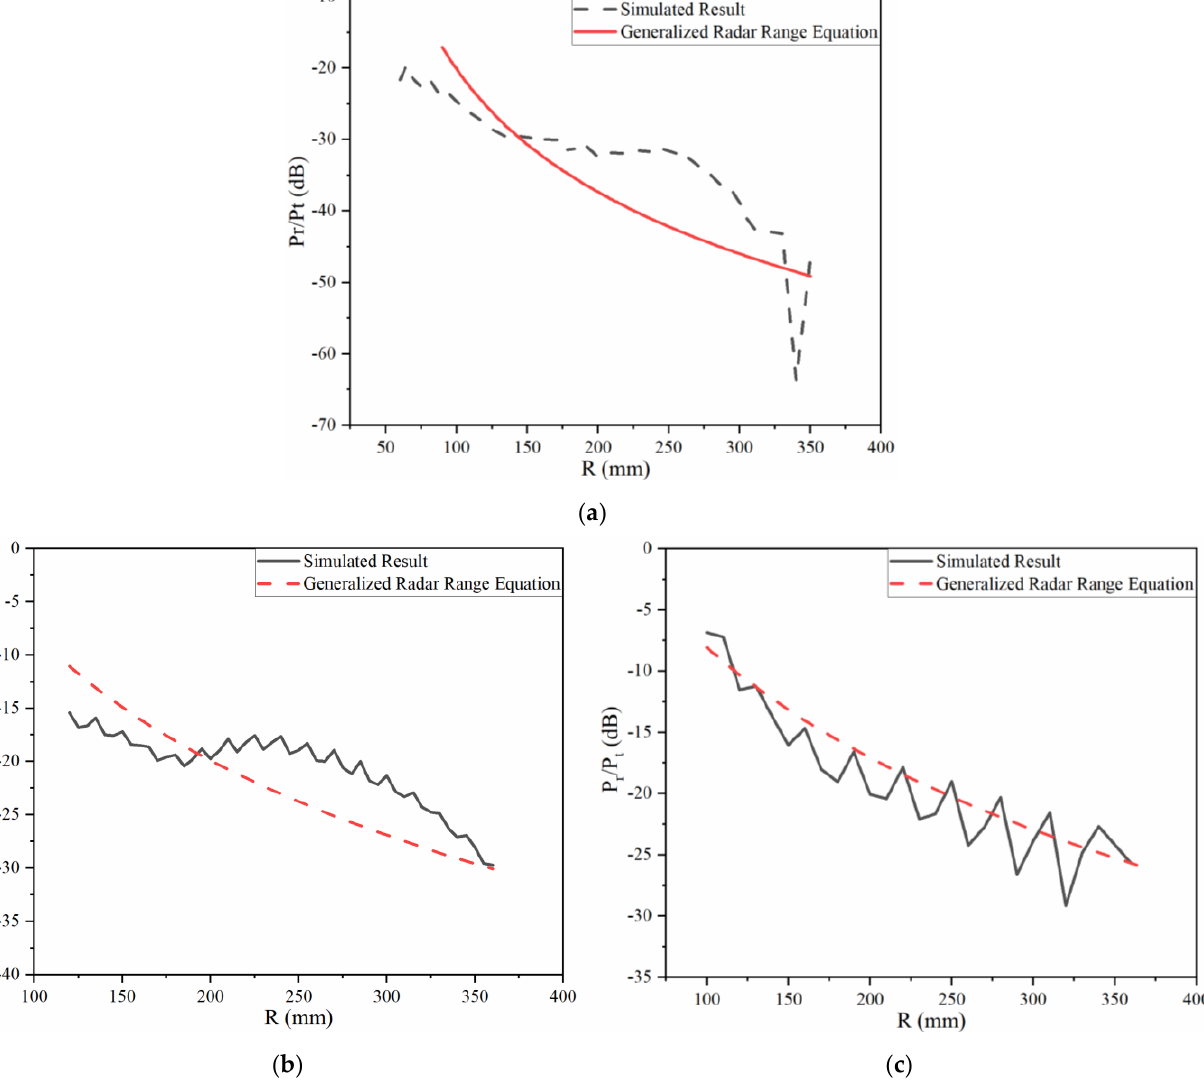
Figure 6. Results of ( P r / P t ) dB obtained by the full-wave simulation and the generalized radar range equation. ( a ) Metal sphere, ( b ) metal plate, ( c ) metal cylinder.